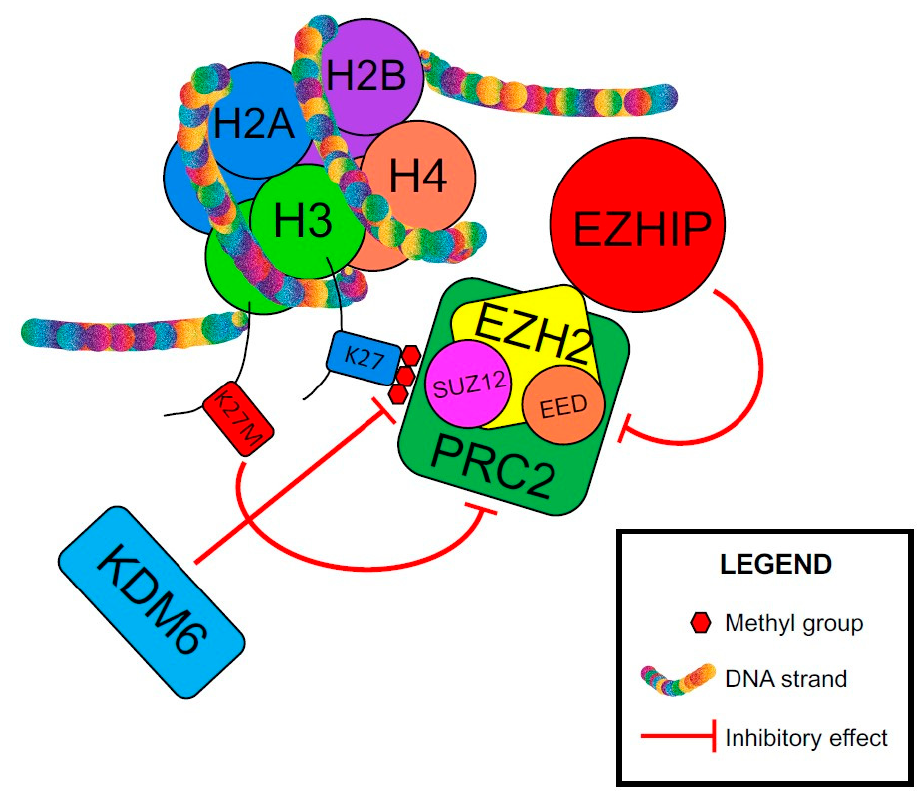
Figure 3. Mechanism of tumorigenesis in posterior fossa ependymoma Group A (PFA). EED—embryonic ectoderm development, EZH2—enhancer of zeste homolog 2, EZHIP—EZH inhibitory protein or Cxorf67, H2A—histone 2A, H2B—histone 2B, H3—histone 3, H4—histone 4, K27—lysine 27 on histone H3, K27M—methionine substitution for lysine on histone 3, KDM6—lysine-specific demethylase 6, PRC2—polycomb repressive complex 2, SUZ12—suppressor of zeste 12